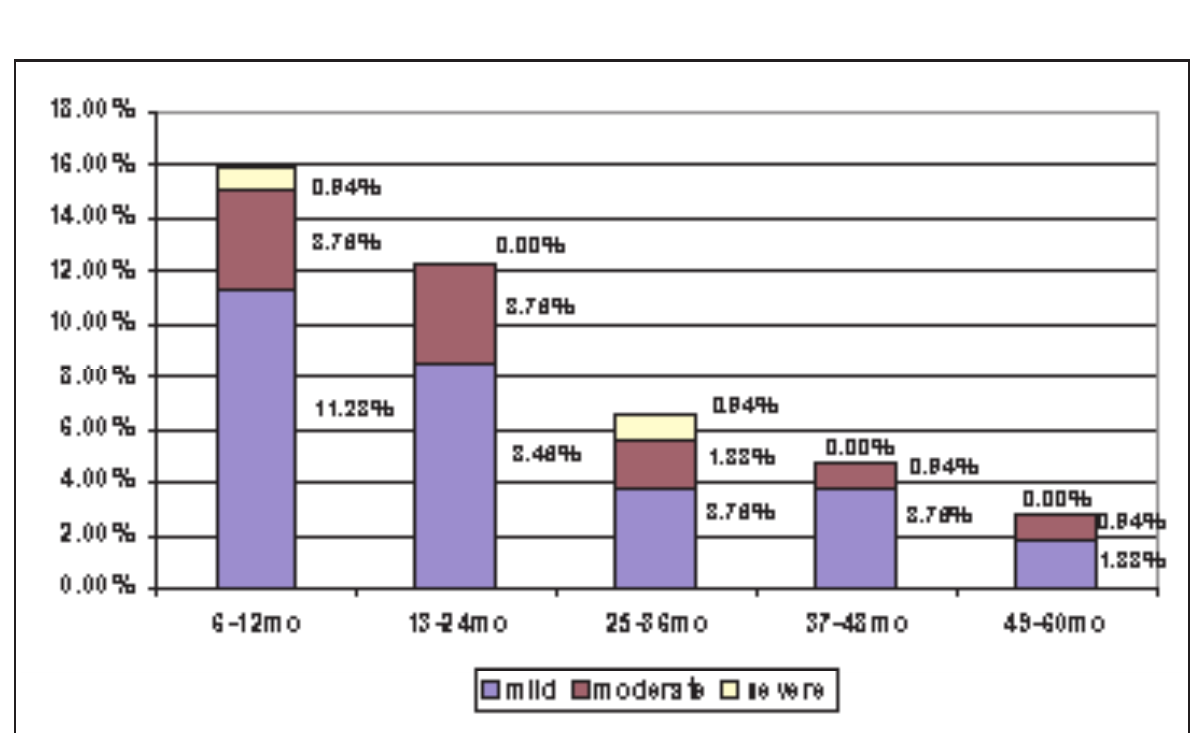
(Females).Fig. 3: Anemia according to age